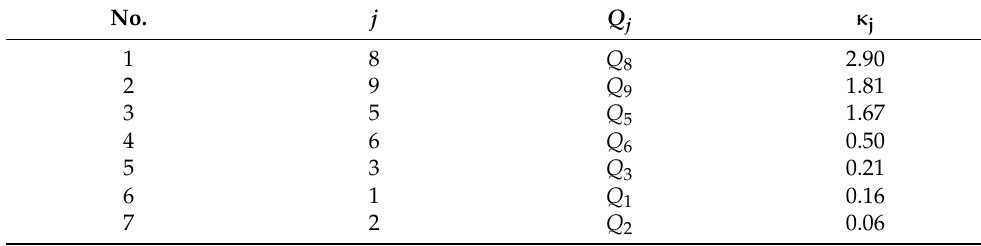
Table 13. A Ranking List of the Dominant Nodal Reactive Powers when the Index κ is Adopted as Criterion for Case